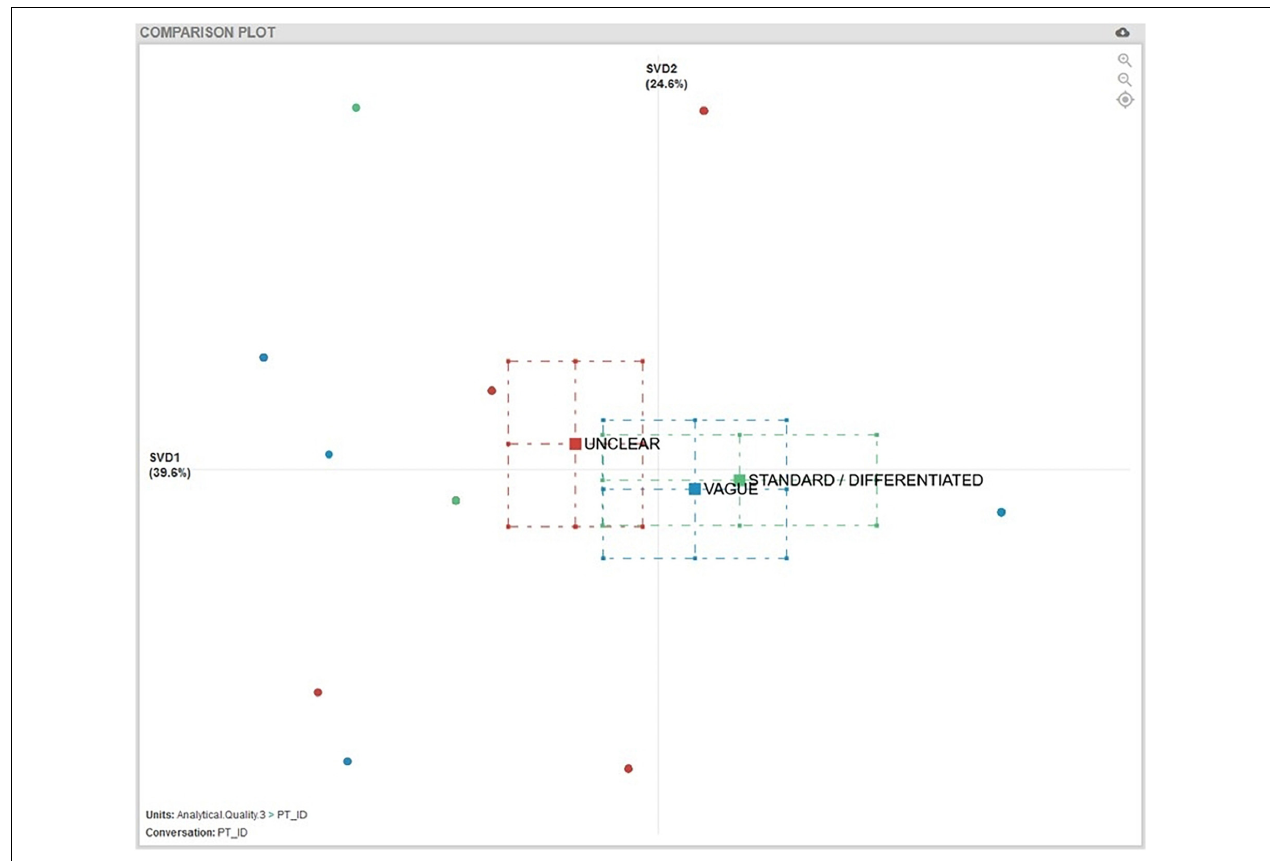
FIGURE 6 | Position of interpret mean networks on ENA projection space. This Figure shows the ENA space for the interpret indicator quality networks and the three quality mean networks distributed on the space. Due to the lower frequency of their occurrence, the standard and differentiated quality indicators were combined into one group. Participants with at least one unclear, vague, or standard/differentiated interpretation, respectively, formed the nested quality groups. For the Interpret mean networks, Unclear n = 34 participants; Vague n = 35 participants; and Standard/differentiated n = 19